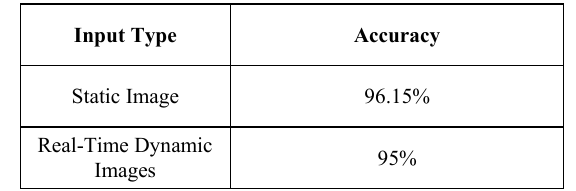
Table 1. Classification Accuracy of CNN Model on static and Dynamic